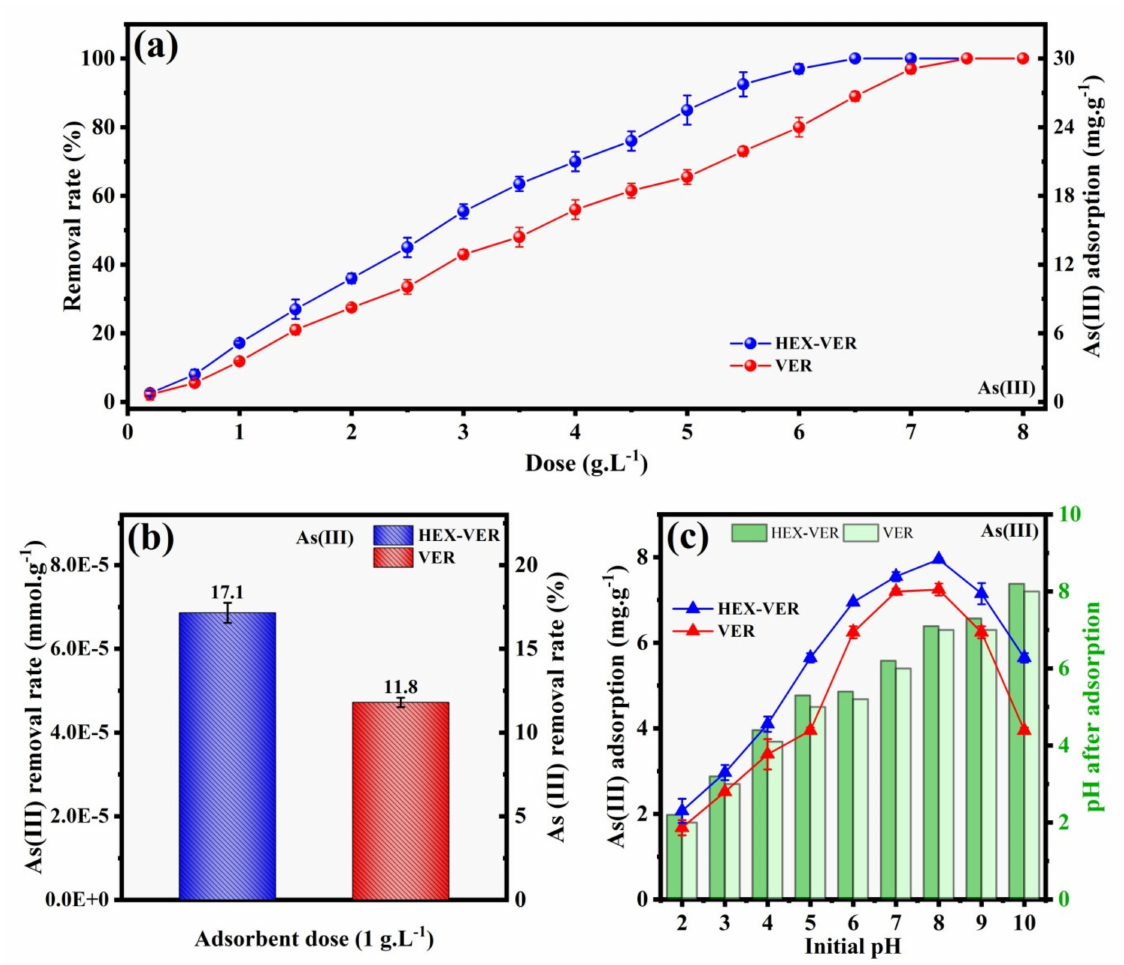
Figure 3. Effect of VER and HEX–VER dose at pH 5 on As(III) at 0.2~8 mg · L − 1 ( a ); Adsorption at 1 g · L − 1 dose from molar perspective for As(III) ( b ); Effect of pH in the range of pH 2~10 for As(III) ( c ); all above experiments at As(III) C i = 30 mg · L − 1 ; contact time, 1440 min; temperature, 30 ◦ C; pH,